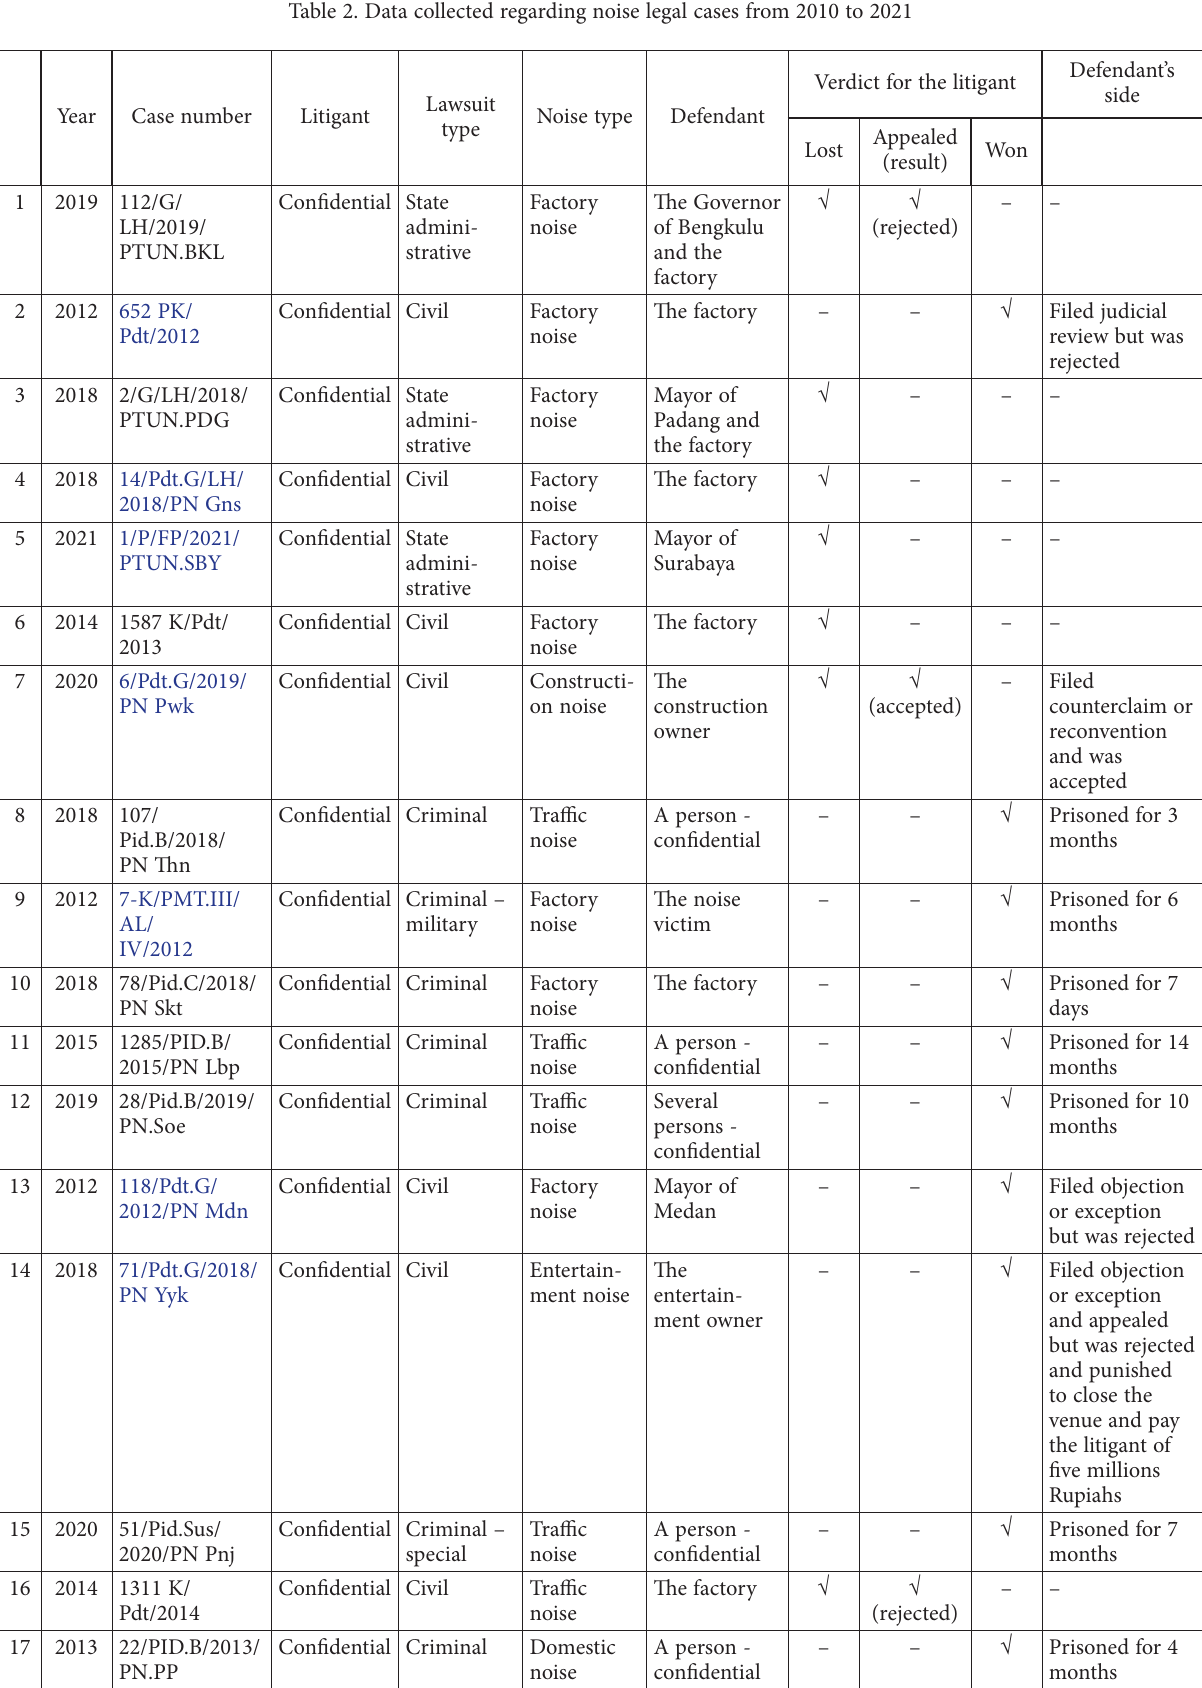
Table 2. Data collected regarding noise legal cases from 2010 to